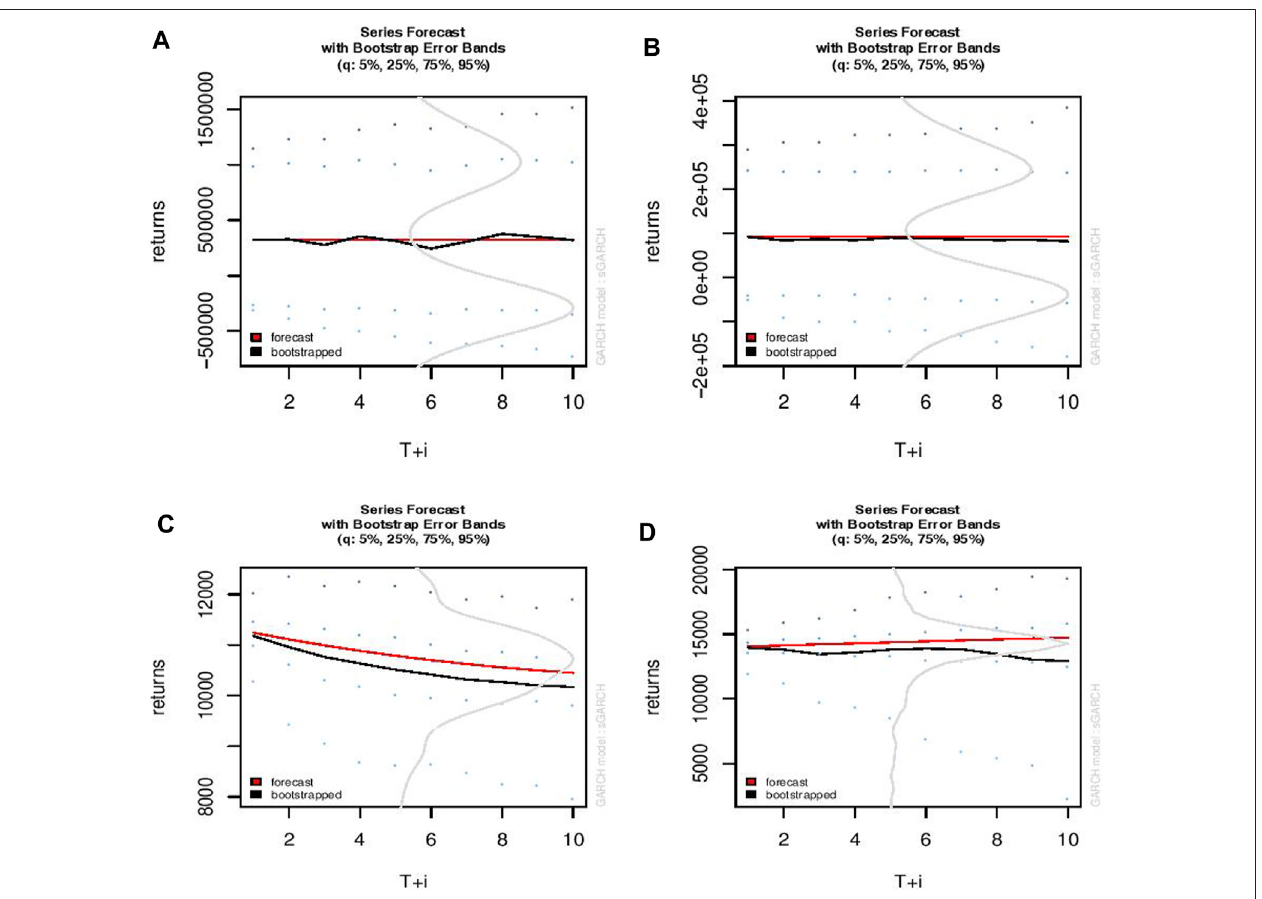
FIGURE5| Predictionofthetrendsofroadcrashesanditsconsequencesforthenext10yearsinSouthAfricausingGARCHmodel. (A) (cid:1) numberofcrashes(road crashes), (B) (cid:1) number of casualties, (C) (cid:1) number of fatal crashes and (D) (cid:1) number of persons killed.